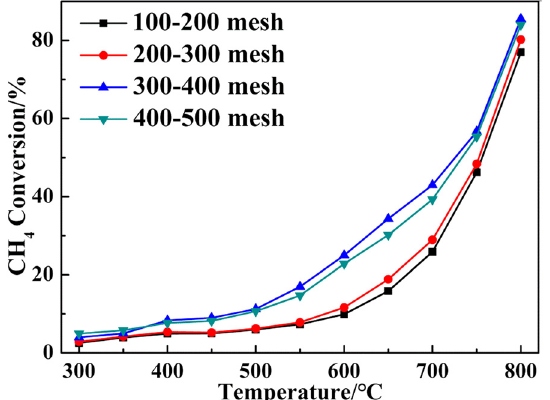
Figure 3: E ff ect of the original mineral particle size on the methane